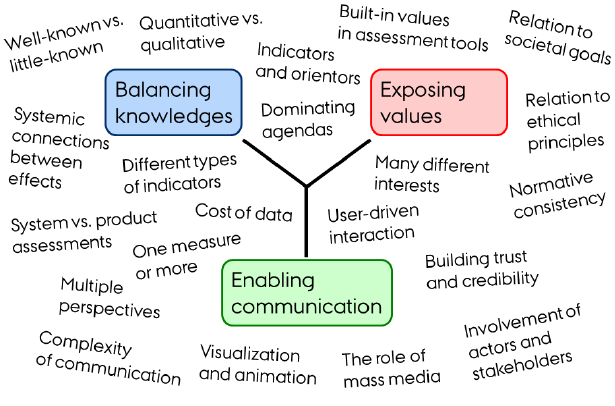
Fig. 1 . Three key challenges in developing multicriteria assessments of food system sustainability, shown in relation to some of the problematic issues